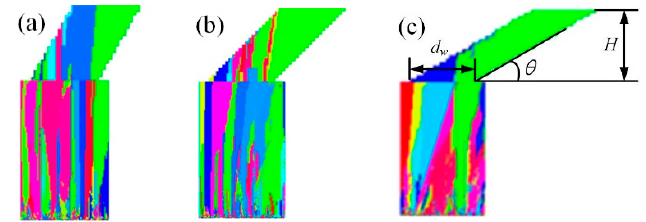
Figure 10. Simulation analysis of grain selection effect for different spiral angles ( H = 14 mm and d w = 12 mm): ( a ) θ = 60° and h > 14 mm, ( b ) θ = 45° and h = 14 mm, and ( c ) θ = 30° and h = 10 mm; h is appearance height of single crystal.